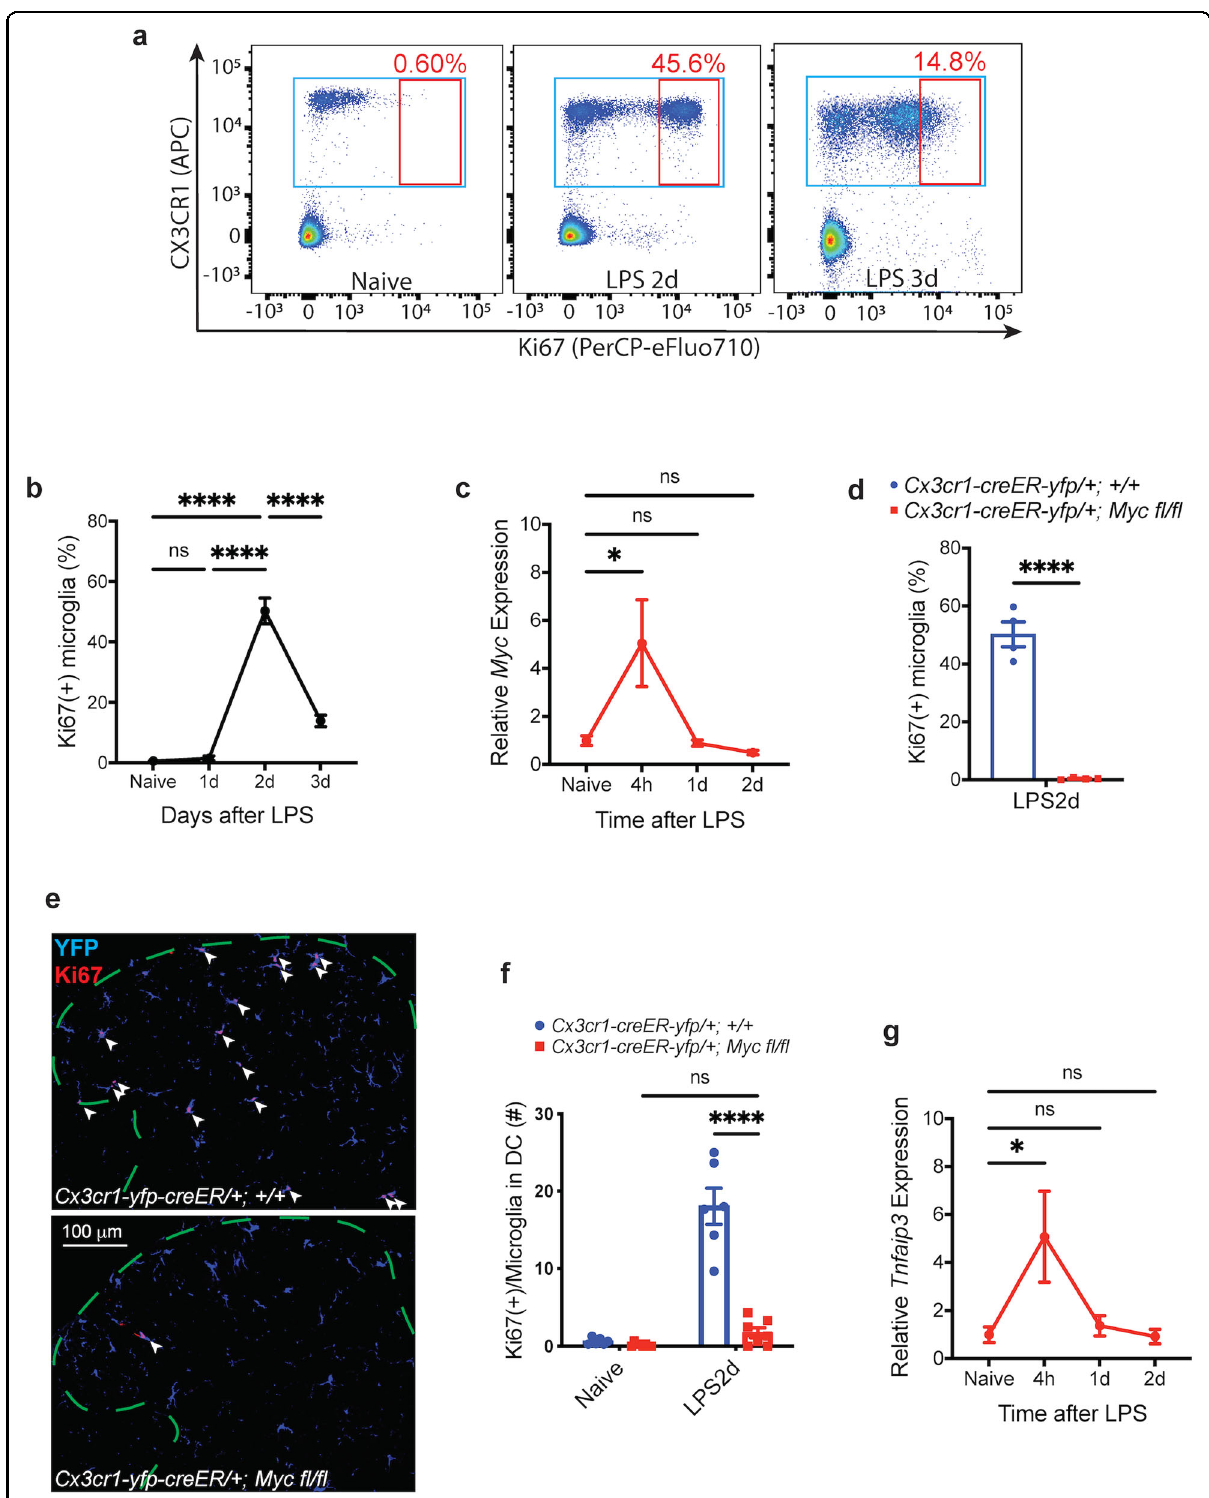
Fig. 8 (See legend on next